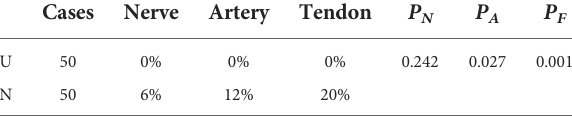
TABLE 4 Comparison of injury rates between the two groups.